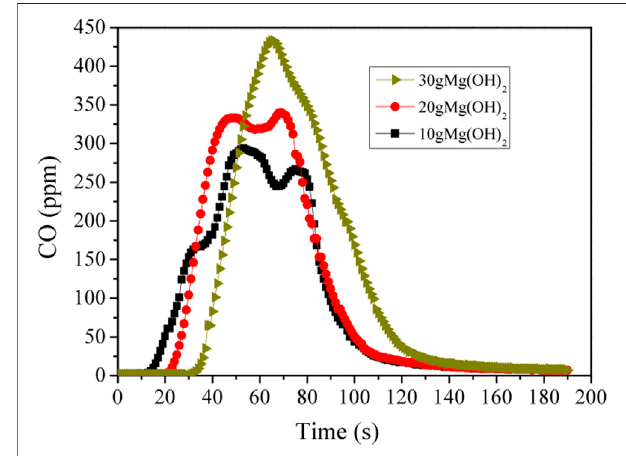
FIGURE 5 | CO concentration by using foam with Mg(OH) 2